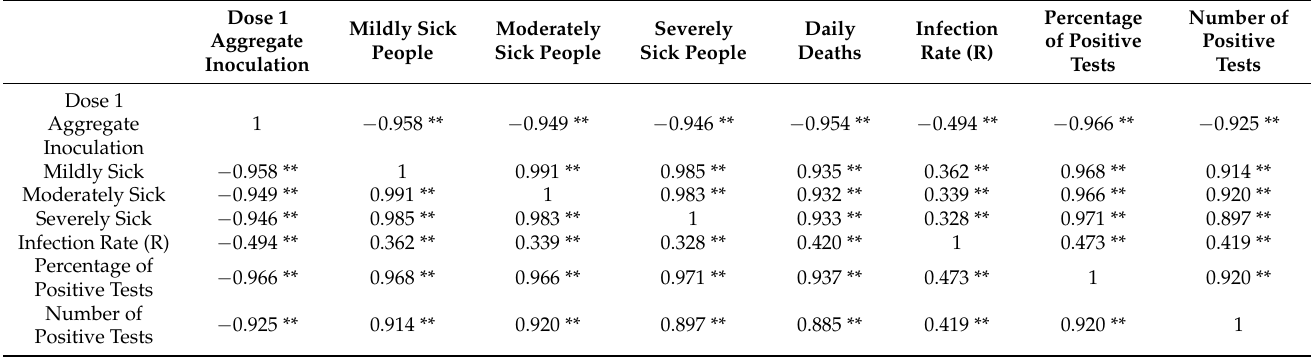
Table 5. Correlation between dose 1 and the sickness factors from 1 January 2021 to 21 May 2021.